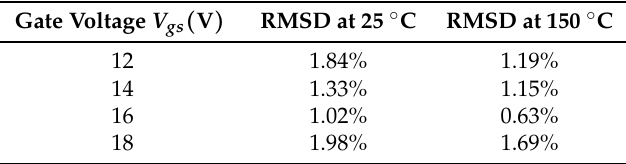
Table 2. Discrepancies between the model and measured